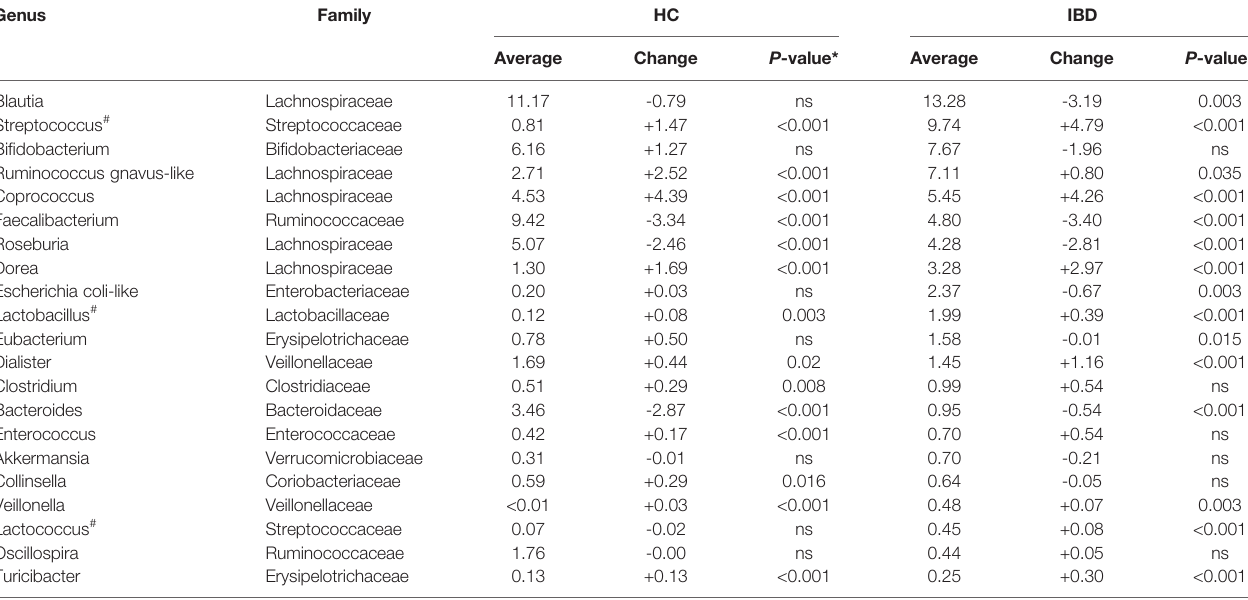
TABLE 2 | Paired analysis of mean bacterial abundances (>0.25) in original, untreated fecal samples versus IgG-coated fecal samples.